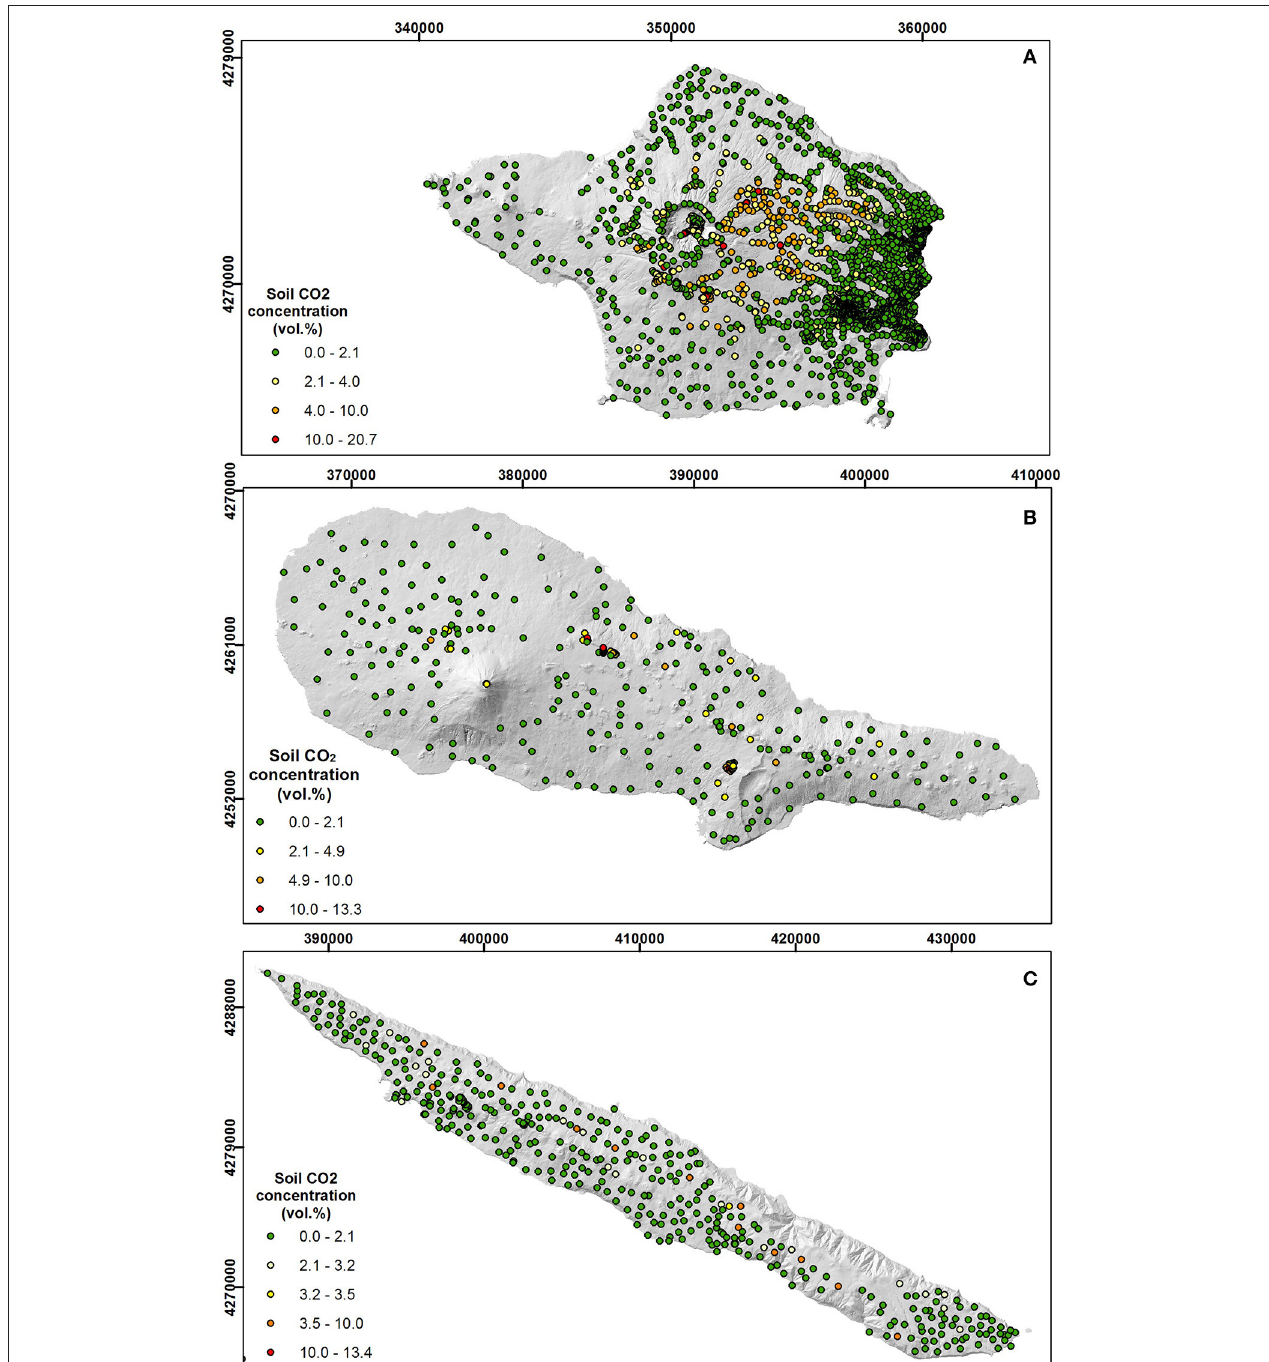
FIGURE 3 | Sampling location and soil CO 2 concentration distribution maps for the studied islands: (A) Faial, (B) Pico, and (C) São Jorge islands.